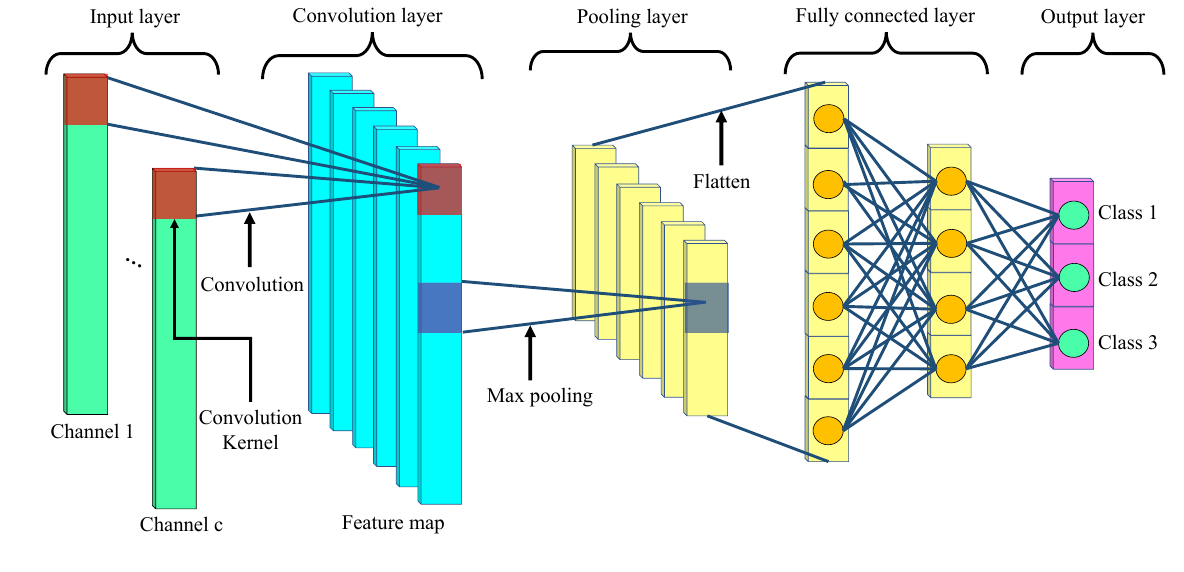
Figure 4. Architecture of the 1DCNN